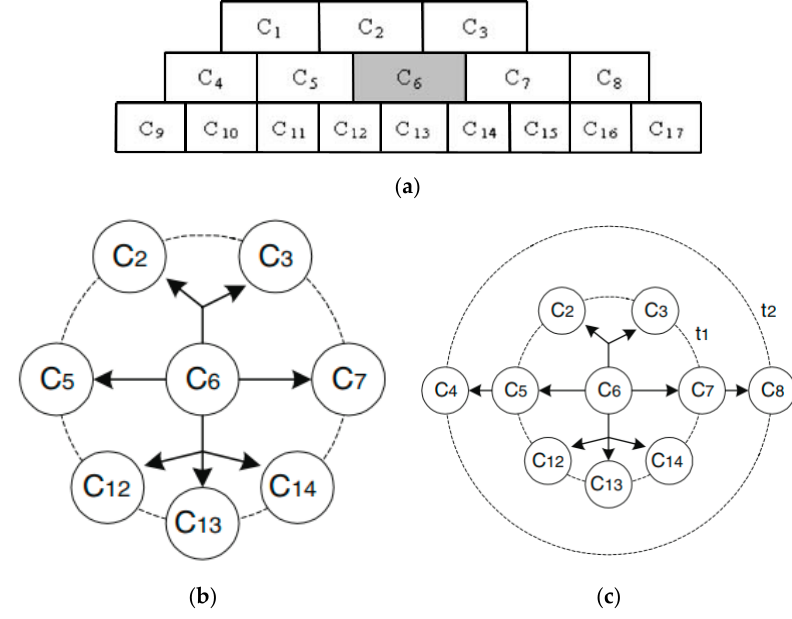
Figure 3. ( a ) Example application 1st method; ( b , c ) example of 1st method: Disassembly wave.